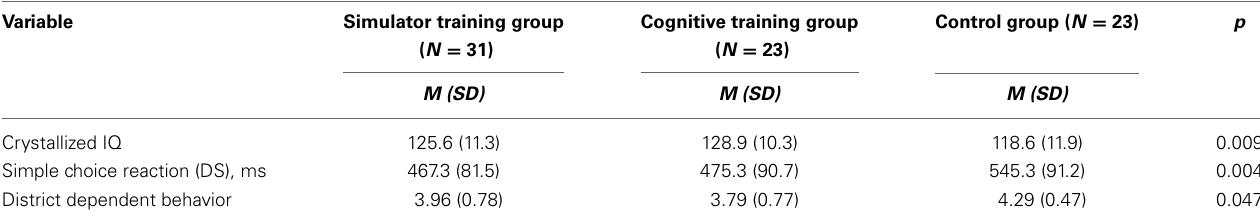
Table 6 | Baseline differences between groups. Variable